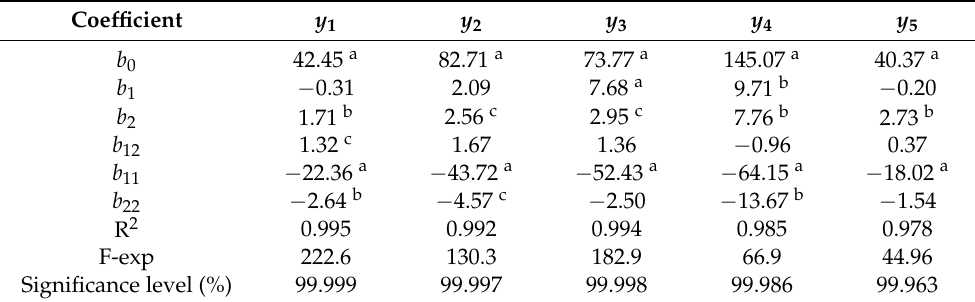
Table 3. Analysis of the variance (ANOVA) of the fitted second-order polynomial models.